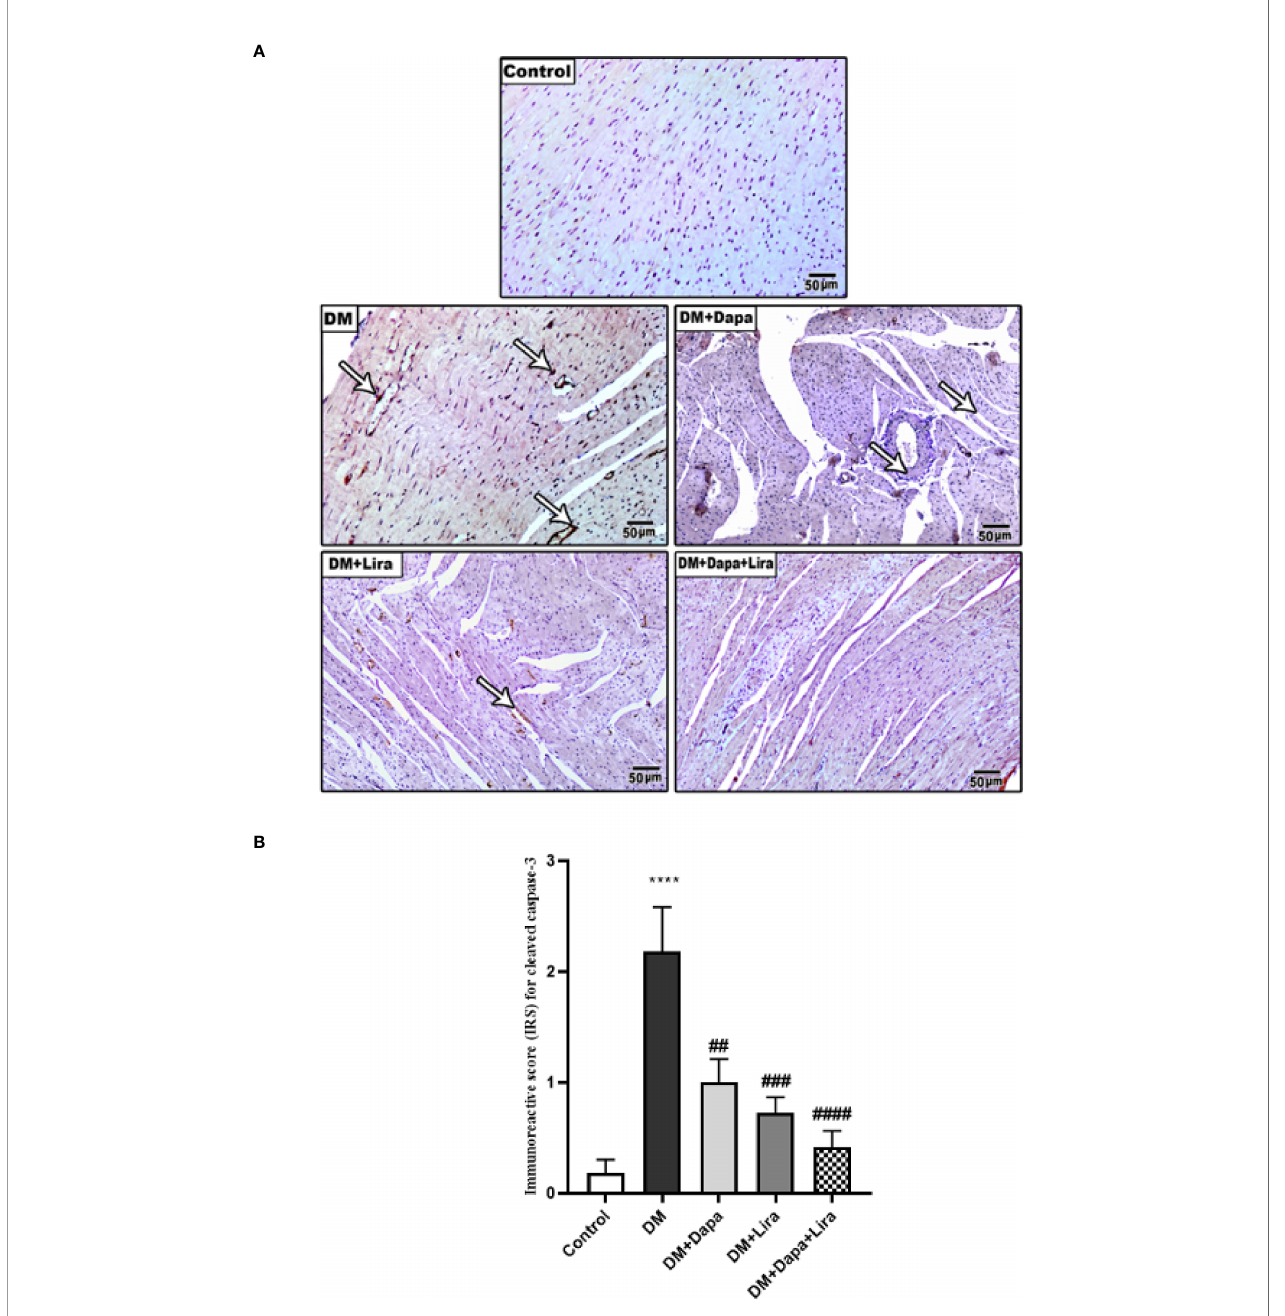
FIGURE 8 | (A) Representative photomicrographs of cleaved caspase-3 immuno-stained cardiac sections from different experimental groups. ×200 bar 50. (B) A graph showing immunoreactive score for cleaved caspase-3 cellular expression. **** Signi fi cance in comparison with control group at p < 0.0001, #### signi fi cance in comparison with diabetic group at p < 0.0001, ### signi fi cance in comparison with diabetic group at p < 0.001, ## signi fi cance in comparison with diabetic group at p <